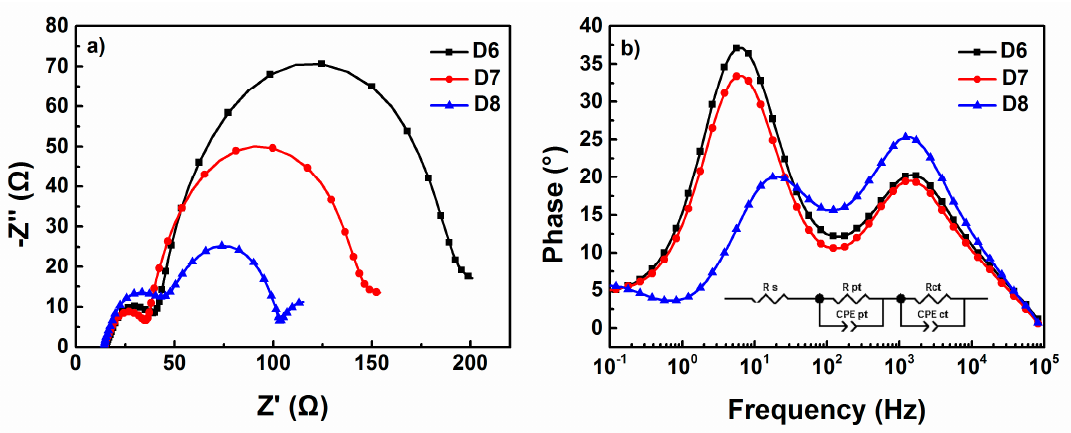
Figure 6. ( a ) Electrochemical impedance spectra (EIS) Nyquist and ( b ) Bode plots for DSSCs based on the dyes.